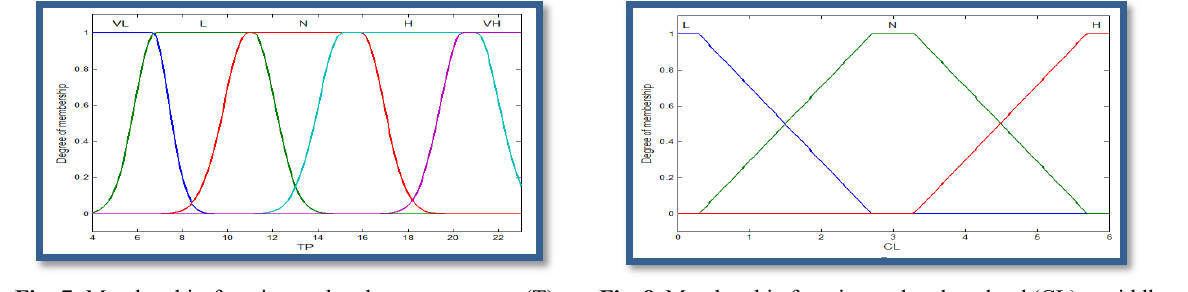
Fig. 8. Membership functions related to cloud (CL) – middle